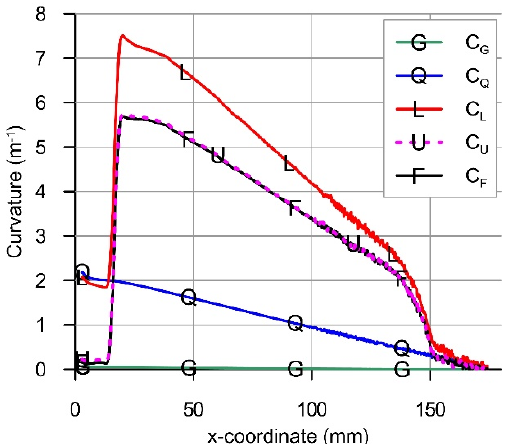
Figure 12. Curvatures G C , Q C , L C , U C and F C of the beam axis in hybrid bending for load case Q5.